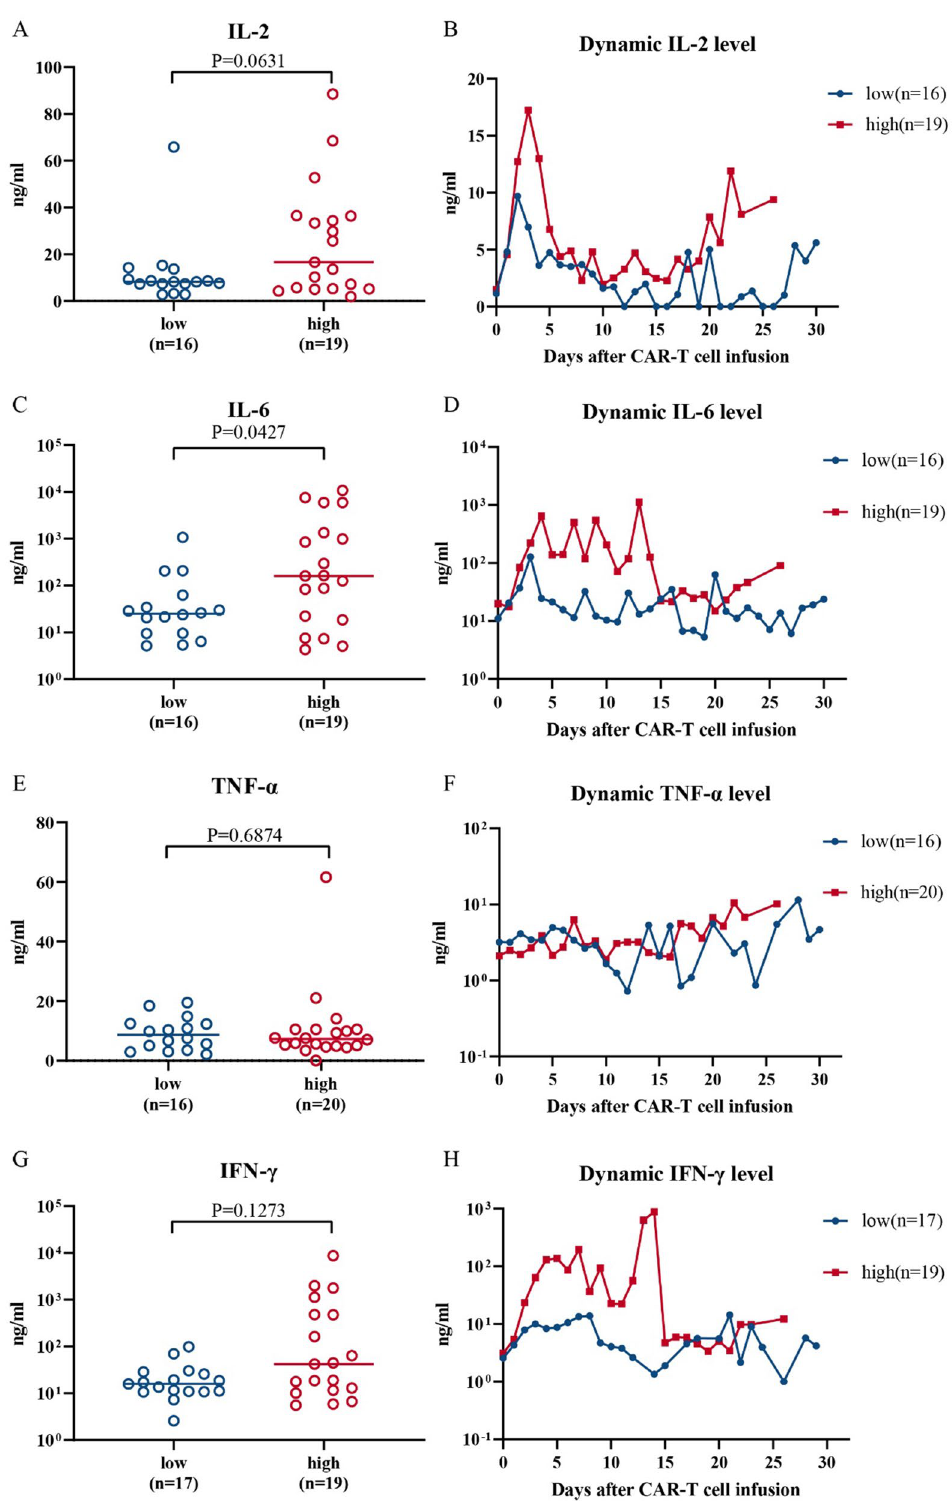
Figure 5. Cytokines and the tumor burden. ( A , C , E , G ) The peak concentration scatter plots of IL-2, IL-6, TNF-α and IFN-γ. ( B , D , F , H ) Plots of the dynamic levels of IL-2, IL-6, TNF-α and